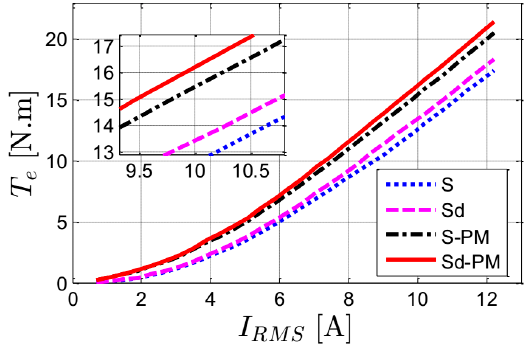
Figure 8. SynRM output torque ( T e ) as a function of stator current ( RMS ) at optimal current angles and rated speed.